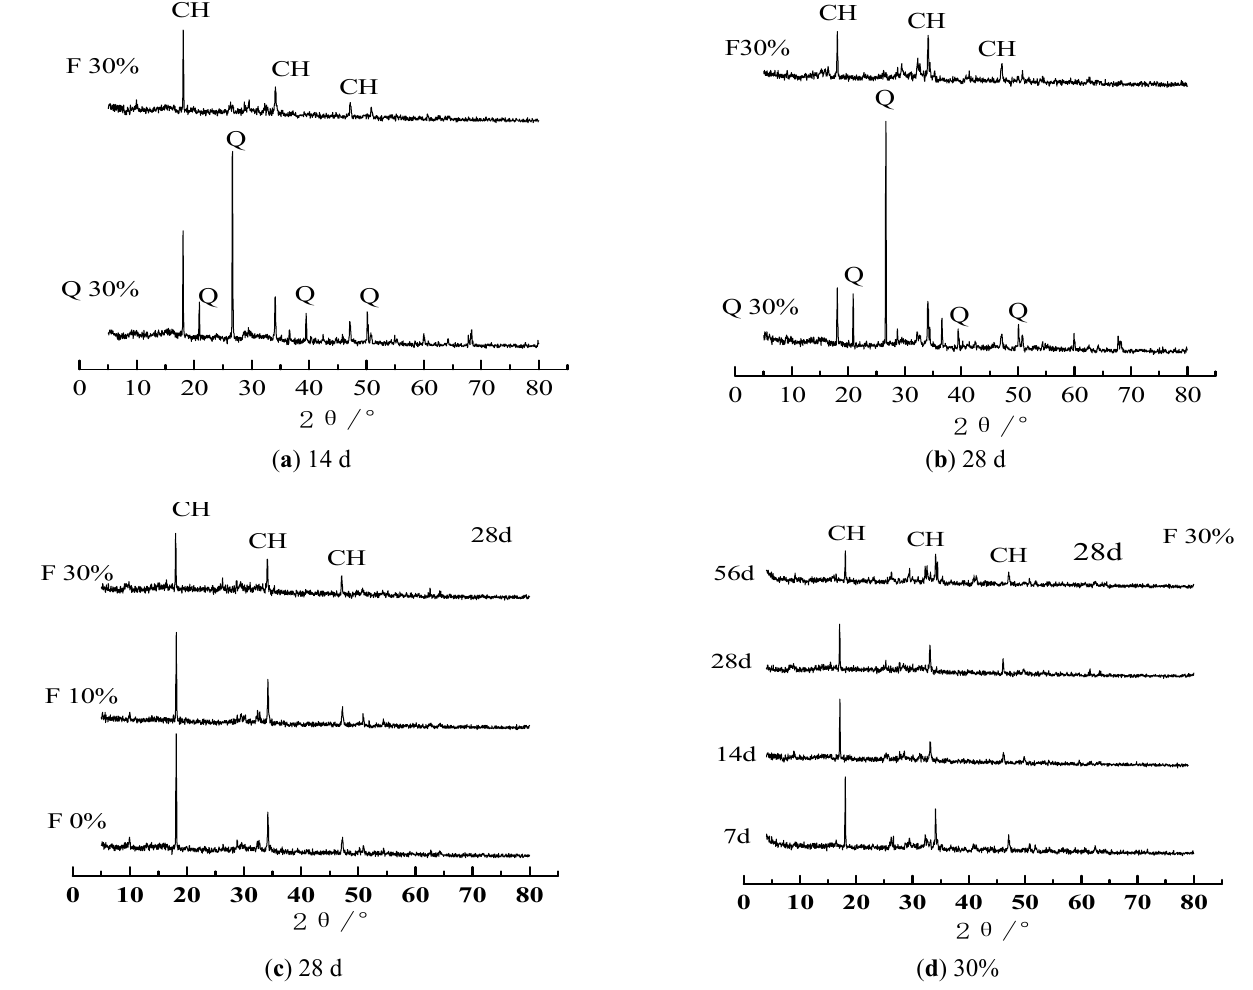
Figure 4. XRD patterns of the hydration products of cement-based materials ( a ) hydration products with 30% F and Q content at 14 d; ( b ) hydration products with 30% F and Q content at 28 d; ( c ) hydration products of different F content at 28 d; ( d ) hydration products of different ages when F content is 30%